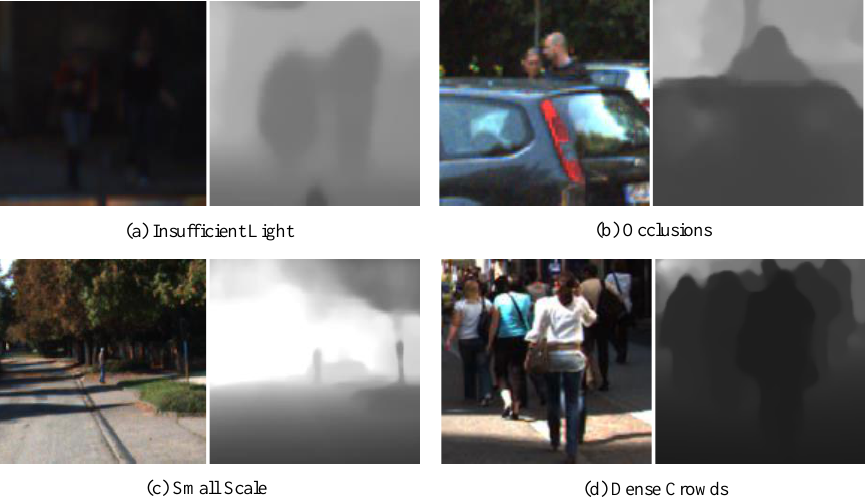
Figure 1. Visualization of RGB and depth images in some challenging pedestrian detection